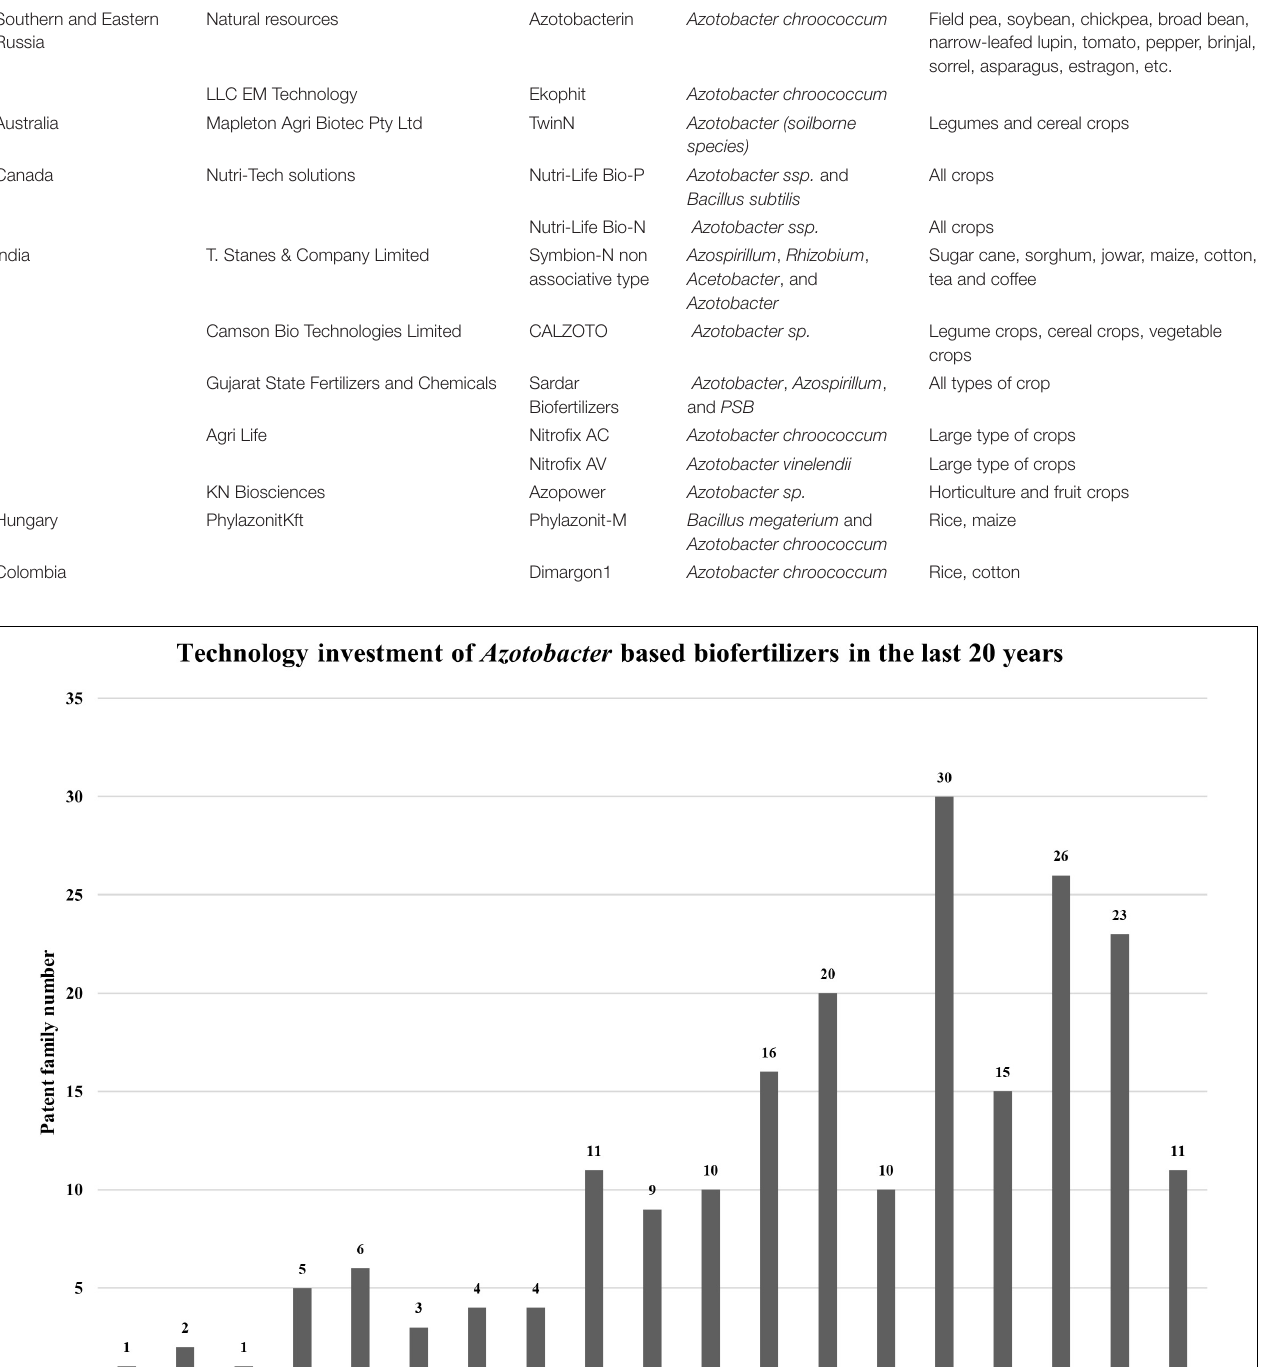
TABLE 2 | Benchmark of Azotobacter based biofertilizers used around the globe (modified from Mishra and Arora, 2016). Country